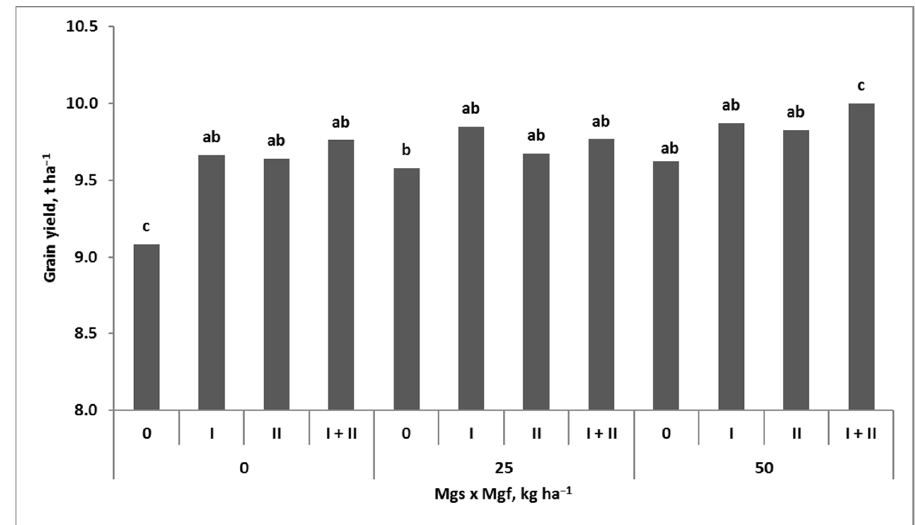
Figure 2. Effect of magnesium fertilization systems on the grain yield of wheat. a, b, c similar letters mean a lack of significant differences using Tukey’s test; Legend: Mgs, Mgf—soil and foliar Mg fertilization system, respectively.